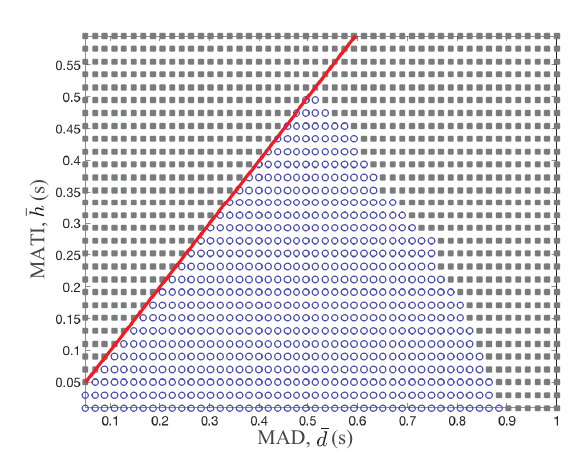
Figure 3. Stability region over different MATI and MAD values. The circle and rectangular marker present the stability and instability operating region of control systems for a given MATI and MAD value.